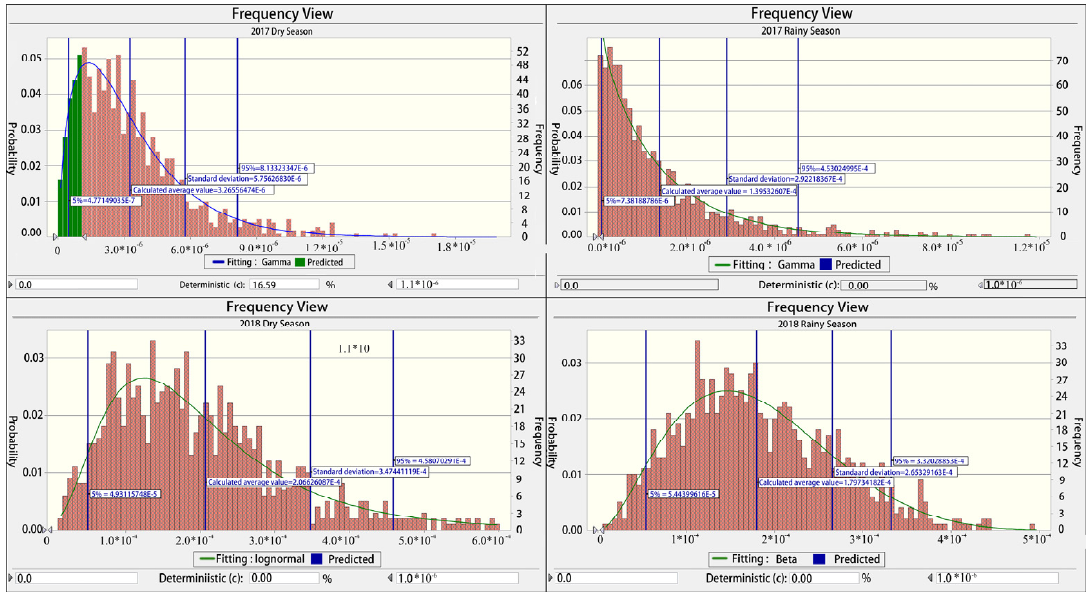
Figure 4. Assessment of the possible carcinogenic health risks to children.